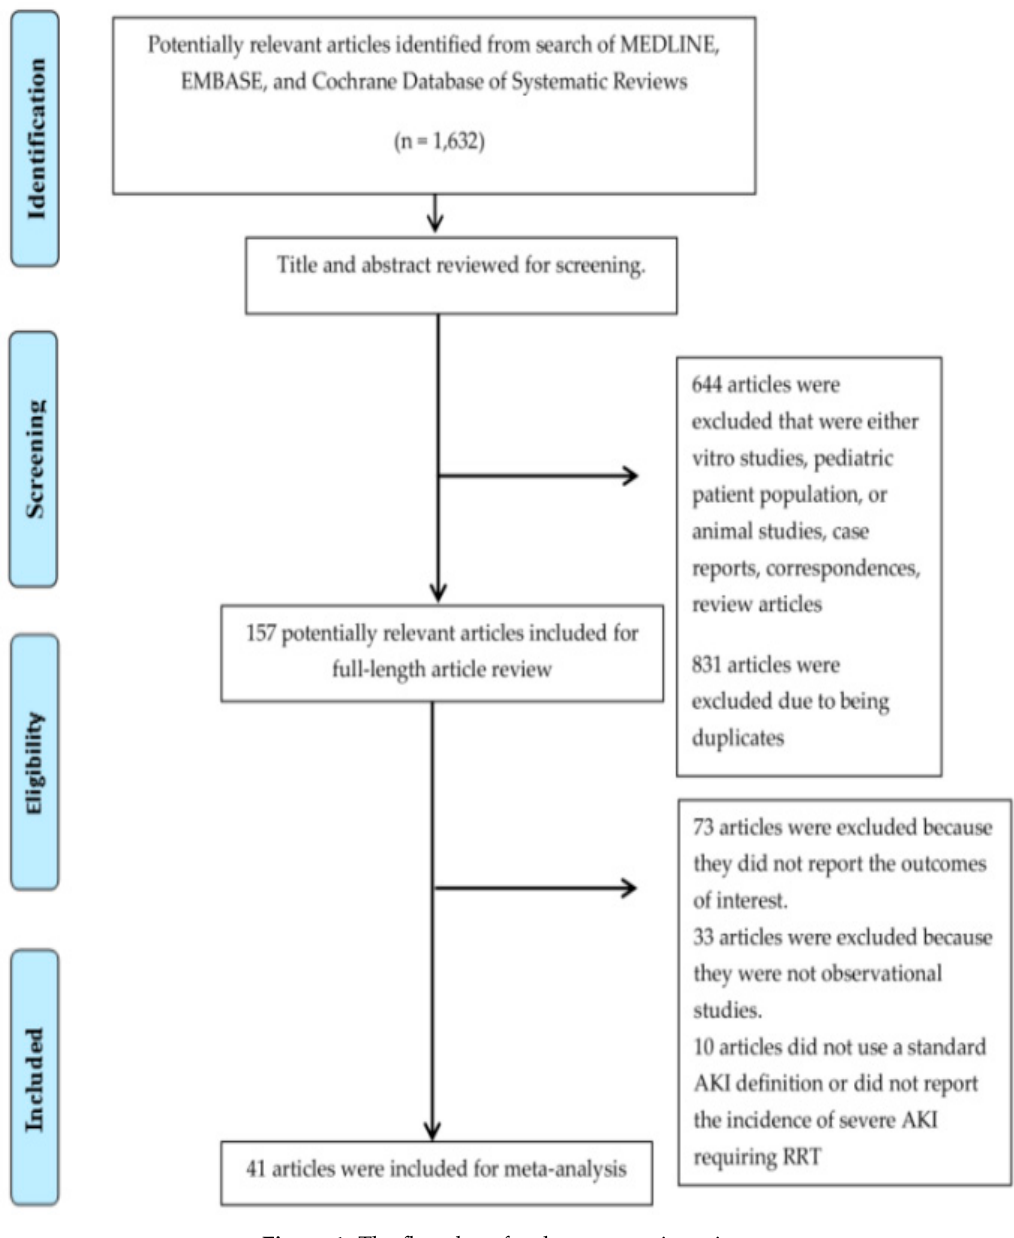
Figure 1. The flowchart for the systematic review.